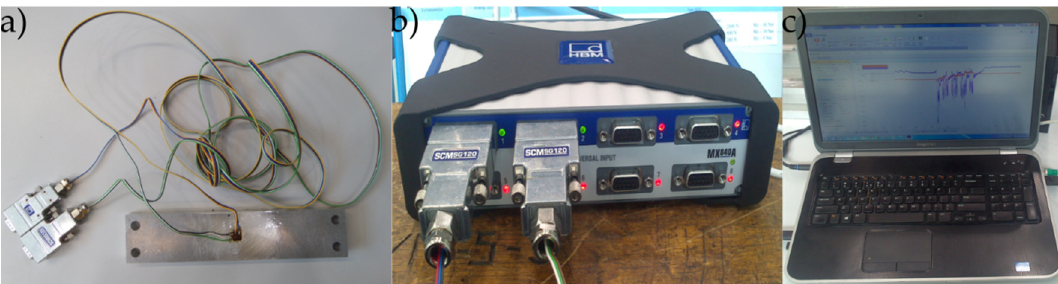
Figure 6. Measurement of deformations using the strain gauge method: ( a ) sample with connected SCMSG120 adapters, ( b ) HBM 1-MX840A amplifier, ( c ) computer with CatmanEasy V35.1 DAQ Project software.